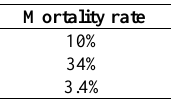
Table 1. Detail of